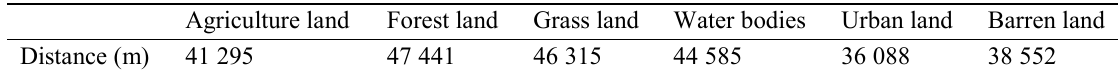
Table 2 Average distance of each land-use type to the corresponding outlet in each